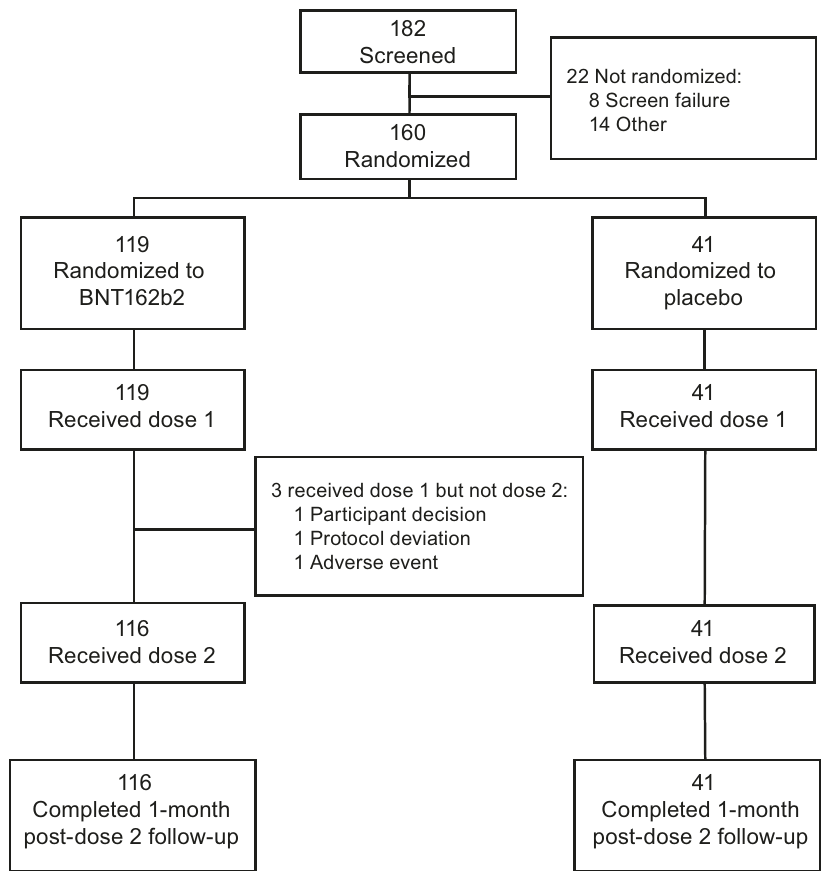
Fig. 1 Study fl ow diagram. Includes all screened and randomized participants. Participants who received dose 1 but not dose 2 continued to be evaluated for safety and immunogenicity.